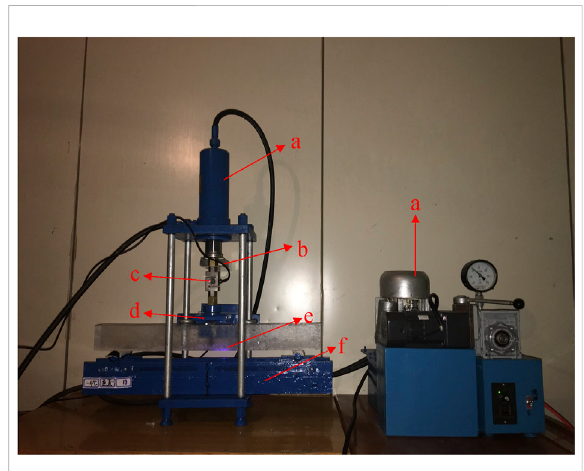
FIGURE 5 (A) The stratigraphy diagram of the ice crystal structure pro fi le, and (B) typical photos of grain types. The ice depth of each vertical or horizontal thin section is also depicted on the lower side.Theactualsizeofeachphotoofahorizontalthinsection is 8 cm × 8 cm.